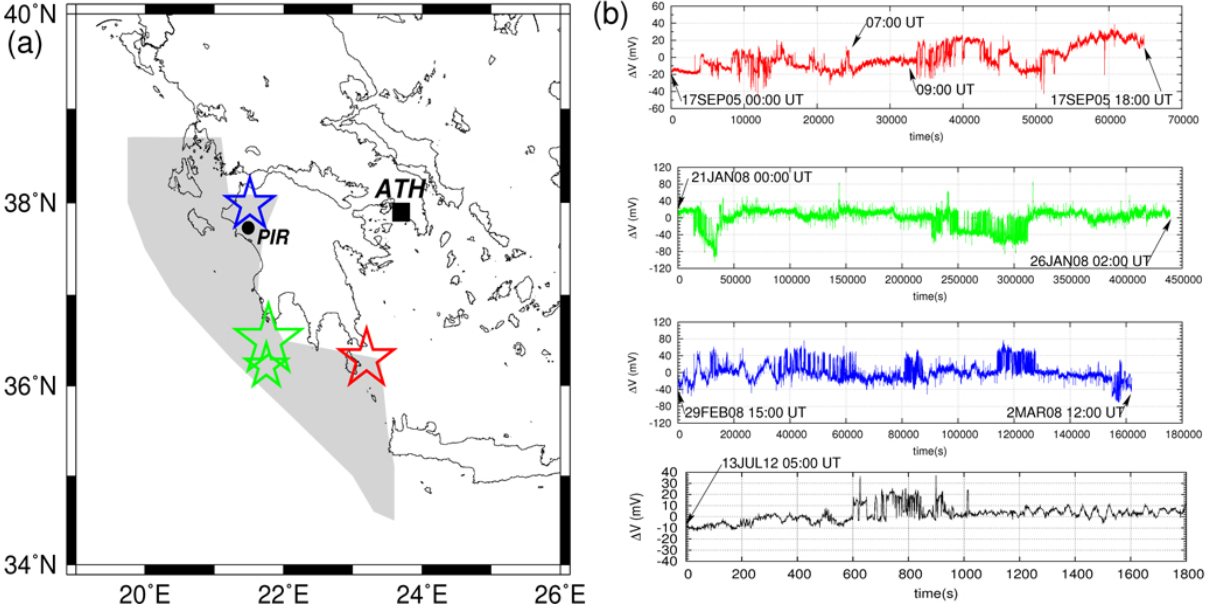
Fig. 1. (color online) (a) Major earthquakes in Greece on 8 January 2006 (red, magnitude M w = 6 . 7), 14 February 2008 (green, M w = 6 . 9 and 6.4) and 8 June 2008 (blue, M w = 6 . 4). (b) Their preceding SES activities recorded at Pirgos (PIR) measuring station located in western Greece are shown (with the corresponding color) in the upper three channels. Earthquakes with SES activities at PIR are located in the shaded region of (a) . Furthermore, an SES activity recorded at a station in northern Greece on 13 July 2012, is depicted in the lowest channel of (b)